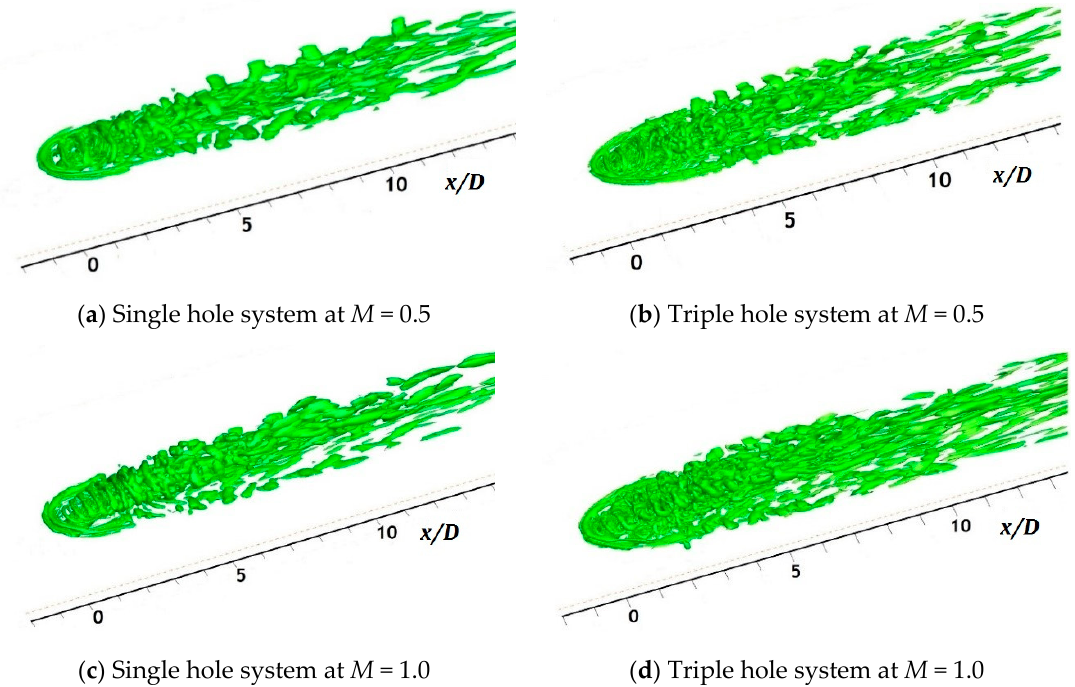
Figure 19. Q-criterion contours with iso-surfaces of level 80,000.